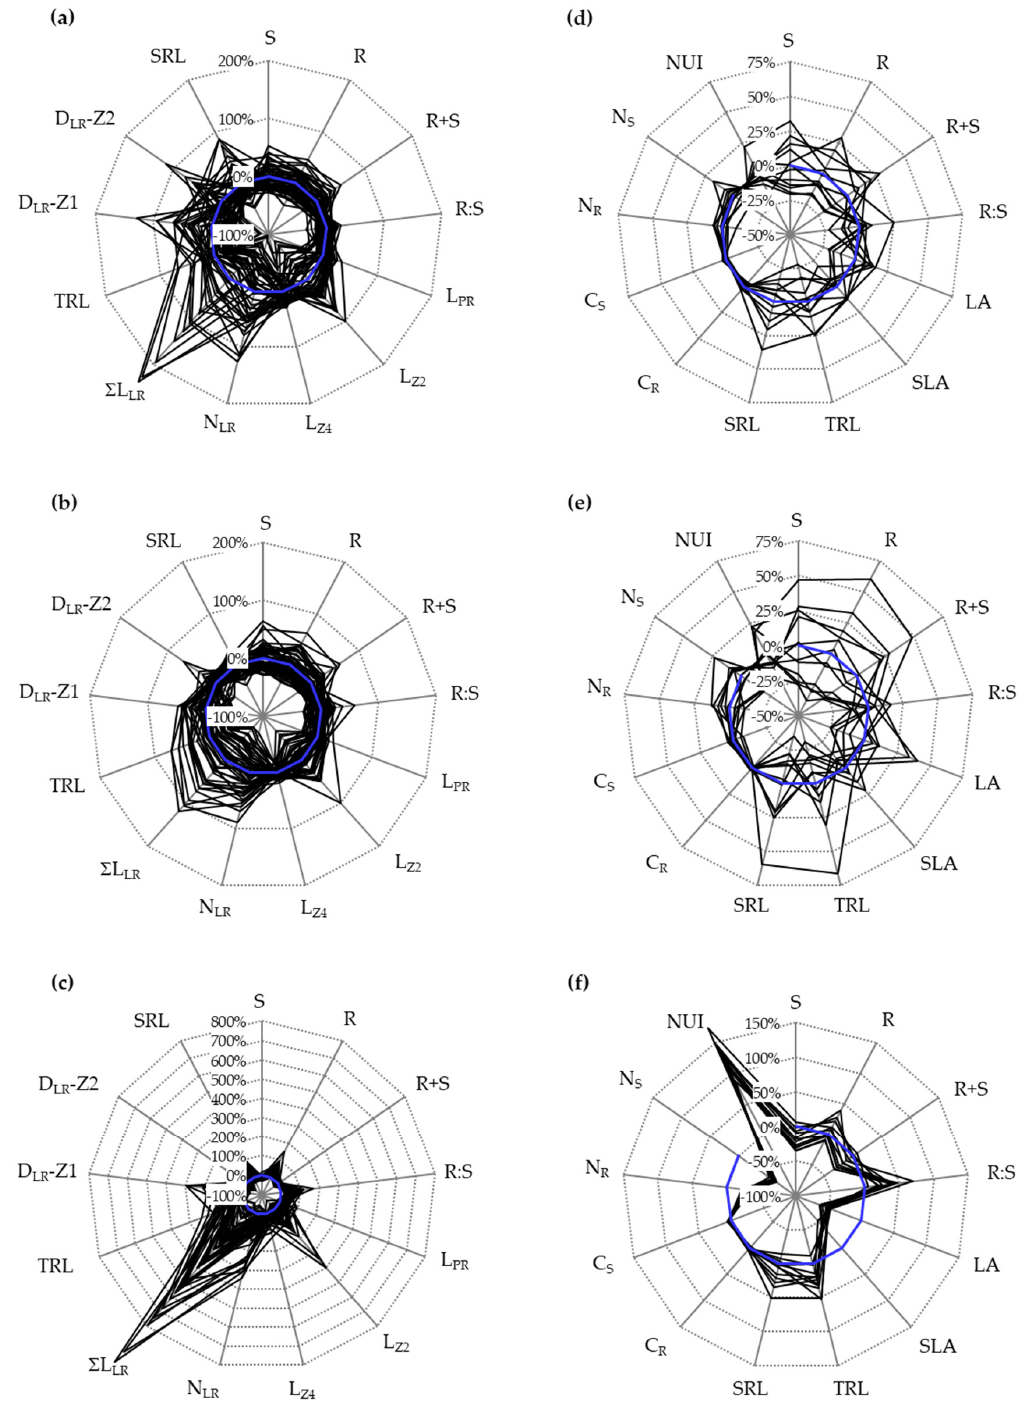
Figure 3. Relative variation of phenotypic traits measured in 55 oilseed rape cultivars cultivated in vitro ( a – c ) and in 12 cultivars in hydroponics ( d – e ). The spider plots ( a , b , d , e ) show the percentage variation of a given trait for every cultivar, normalized by the mean value of the panel, measured during N+ ( a , d ) or N − ( b , e ) conditions. Zero percent (blue circle) indicates no difference compared to the mean value of the panel in one condition. The spider plots ( c , f ) show the percentage variation of a given trait for every cultivar grown during N − , normalized by the value observed during N+ conditions. This defines the responsiveness of one trait to nitrate depletion. Zero percent (blue circle) indicates no difference compared to elevated nitrate conditions. n = 15 plants per genotype and per N condition cultivated in vitro, and 5 plants in hydroponics. Traits are defined in Table 1.